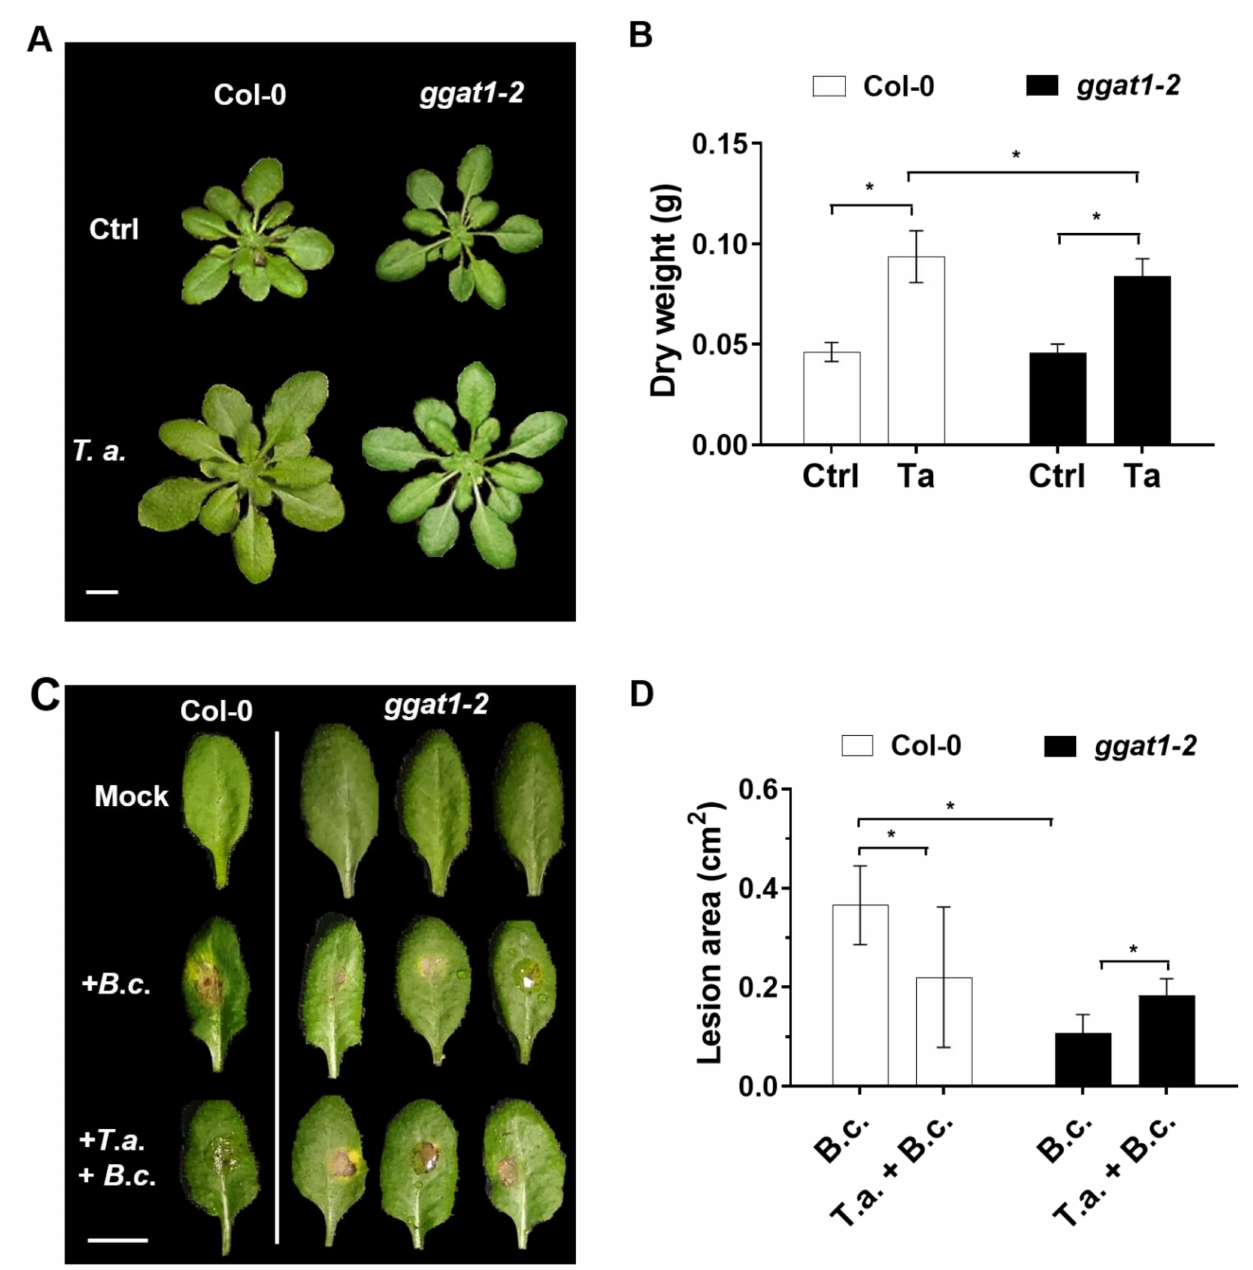
Figure 7. GGAT1 is partially required in Arabidopsis for plant growth induced by T. atroviride and potentially participates in the negative regulation of the systemic resistance against B. cinerea . Two-week-old Arabidopsis plants were root-pretreated with T. atroviride , whereas control plants were inoculated with buffer. ( A ) Plant phenotypes of growth response to T. atroviride . Pictures were taken at 18-days post-treatment. Scale bar, 1 cm. ( B ) Dry weights of individual plants were determined at 21 days post-treatment. The experiments were repeated thrice with similar results. The data represent the means of 20 plants. Results were analyzed using a Tukey multiple comparison test ( α = 0.05). Asterisks indicate p < 0.05. ( C ) Comparison of leaves damage between Col-0 and ggat1-2 seedlings inoculated with B. cinerea (+ B . c ). Plants treated with inoculation buffer were included as control (mock). Infections were carried out on three leaves from each plant previously treated or not with T. atroviride (18 days post-treatments, T . a . + B . c .). Pictures were taken at six days post infection. Scale bar, 1 cm. ( D ) Lesion sizes (cm 2 ) of Arabidopsis leaves infected with B. cinerea were analyzed at six-days post infection (dpi) using ImageJ software. The experiments were repeated thrice with similar results. The data represent means of 24 leaves from a total of eight plants. Results were analyzed using a Tukey multiple comparison test ( α = 0.05). Asterisks indicate p < 0.05. Error bars indicate